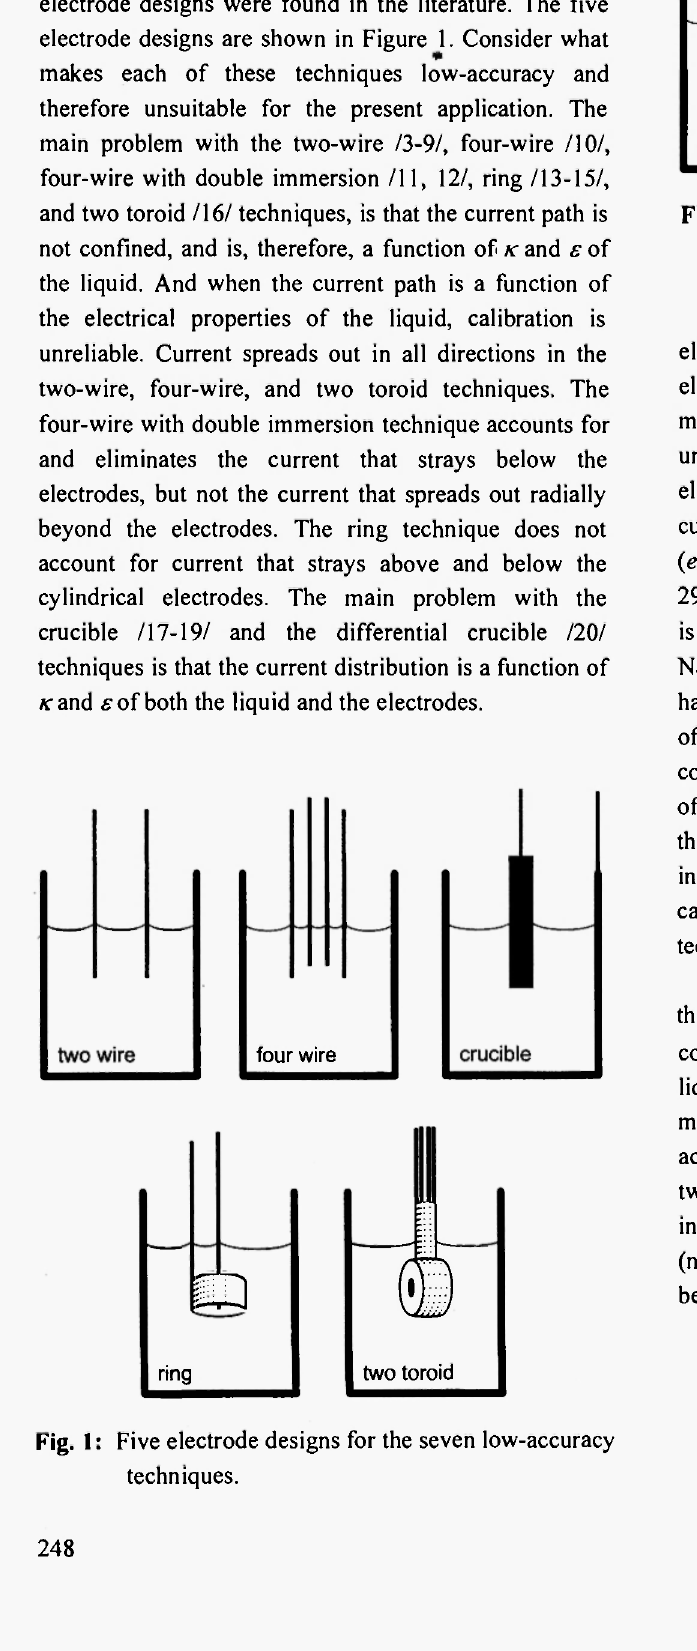
Fig. 2: Three electrode designs for the four high- accuracy